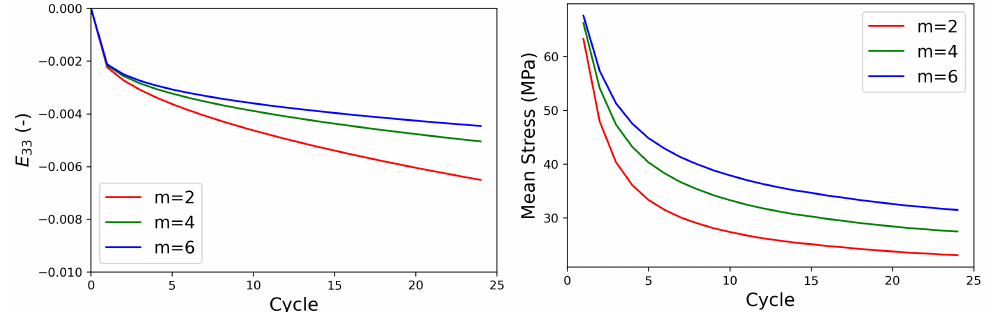
Figure A2. Effect of the kinematic hardening parameter m on the axial creep behavior and the mean stress relaxation during HPTF